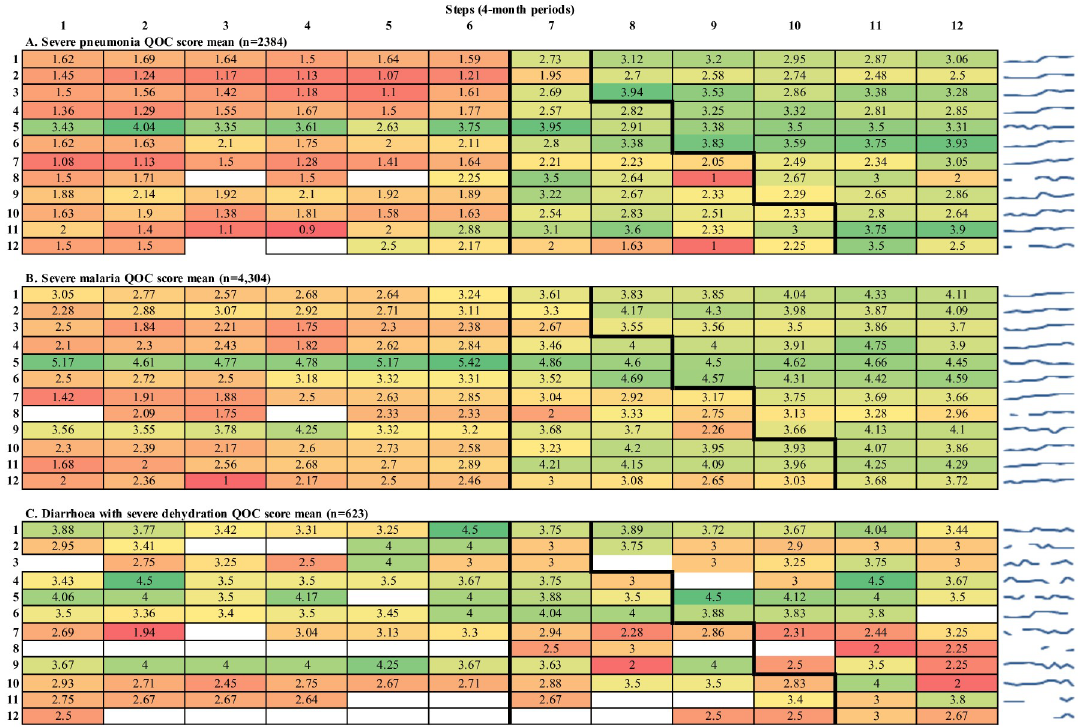
Fig 2. Crude QOC score total means (maximum six points) for severe pneumonia, severe malaria and diarrhoea with severe dehydration, by hospital and step. Each cell contains the crude mean QOC score for a hospital during that step. For each of the three panels in this figure, the 12 hospitals are represented on the y-axis, whereas the steps of the trial are represented on the x-axis. The colour gradient extends from red (lowest score) through yellow to green (highest scores), providing a visual representation of change in scores over time. Blue spark-lines show the hospital- specific trend for easy reference. When the denominator to compute the cell rate is 0, cells are coloured in white. Data from November/December 2013 not available in step 1.